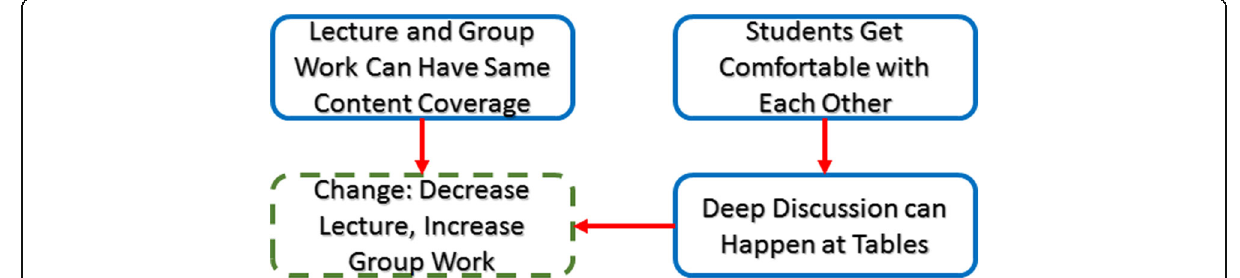
Fig. 5 Revealed Causal Map for Instructor D, changing amount of lecture and group